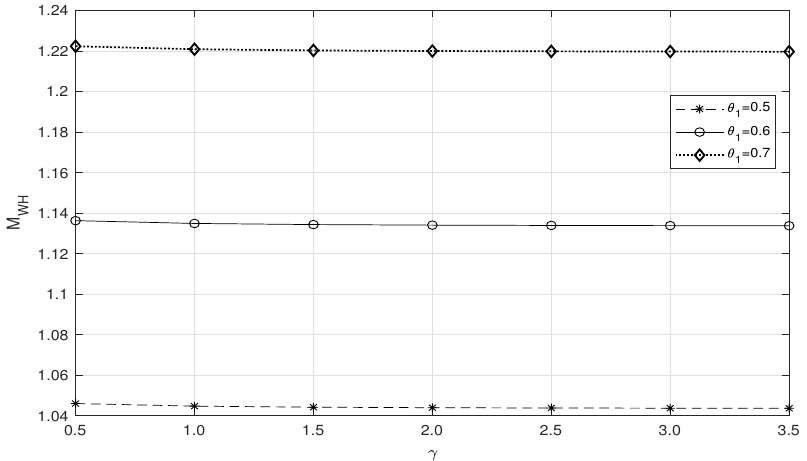
Figure 14. Mean number of customers in the waiting hall on θ 1 vs. γ